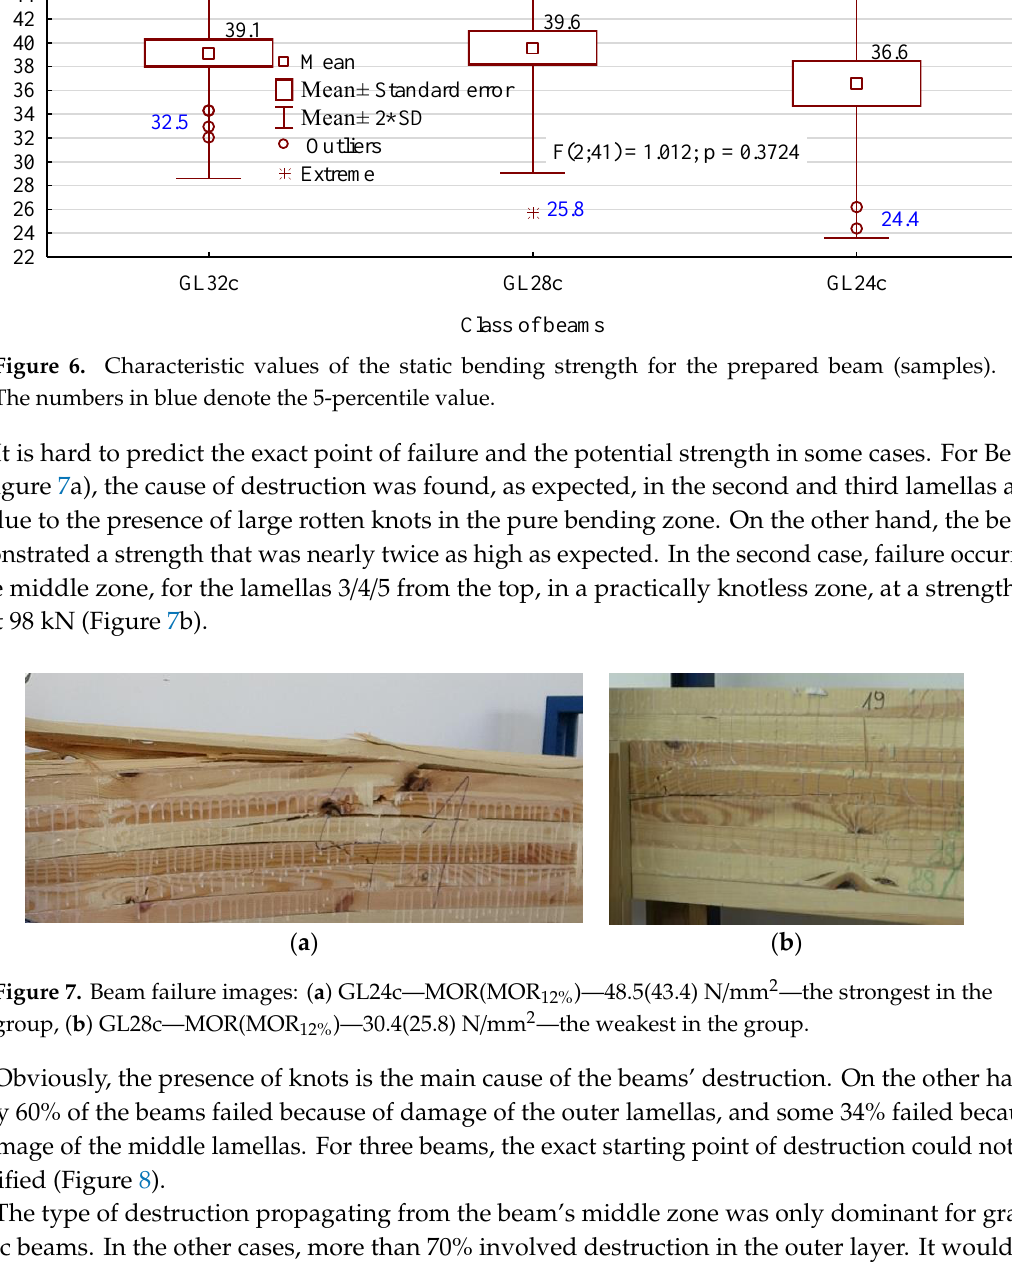
Figure 8. Impact of the point of destruction for various beam grades. The type of destruction propagating from the beam’s middle zone was only dominant for grade GL32c beams. In the other cases, more than 70% involved destruction in the outer layer. It would be unjustified to reject the zero hypothesis that states that the strength of the prepared beams depends on the starting point of the propagation of the destruction (Figure 9). The average static bending strength for the beams destroyed as a consequence of damage to the outer lamellas was 39.6 N/mm 2 , and the value was 37.3 N/mm 2 for those where the destruction originated in the middle layer. A different situation was observed for the modulus of elasticity. In this case, the differences were statistically significant and beams with a higher MOE value were destroyed mainly in the middle layer. This is probably attributable to the fact that the beams with higher moduli of elasticity had higher-quality outer lamellas and were capable of withstanding the arising stress, whereas lower- grade timber, though located deeper, was exposed to critical/damaging stress.